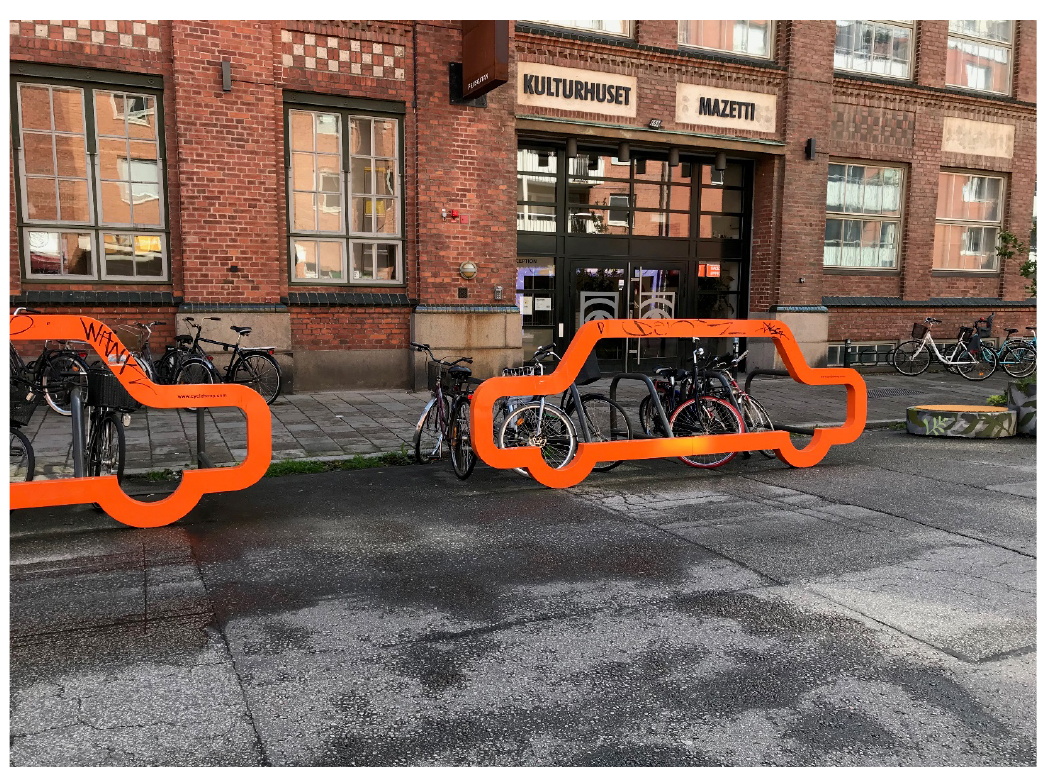
Figure 2. Bike stands displaying the silhouette of a car, Malmö, Sweden. Source: Photo by author. Ireland). A striking case of transnational relocation